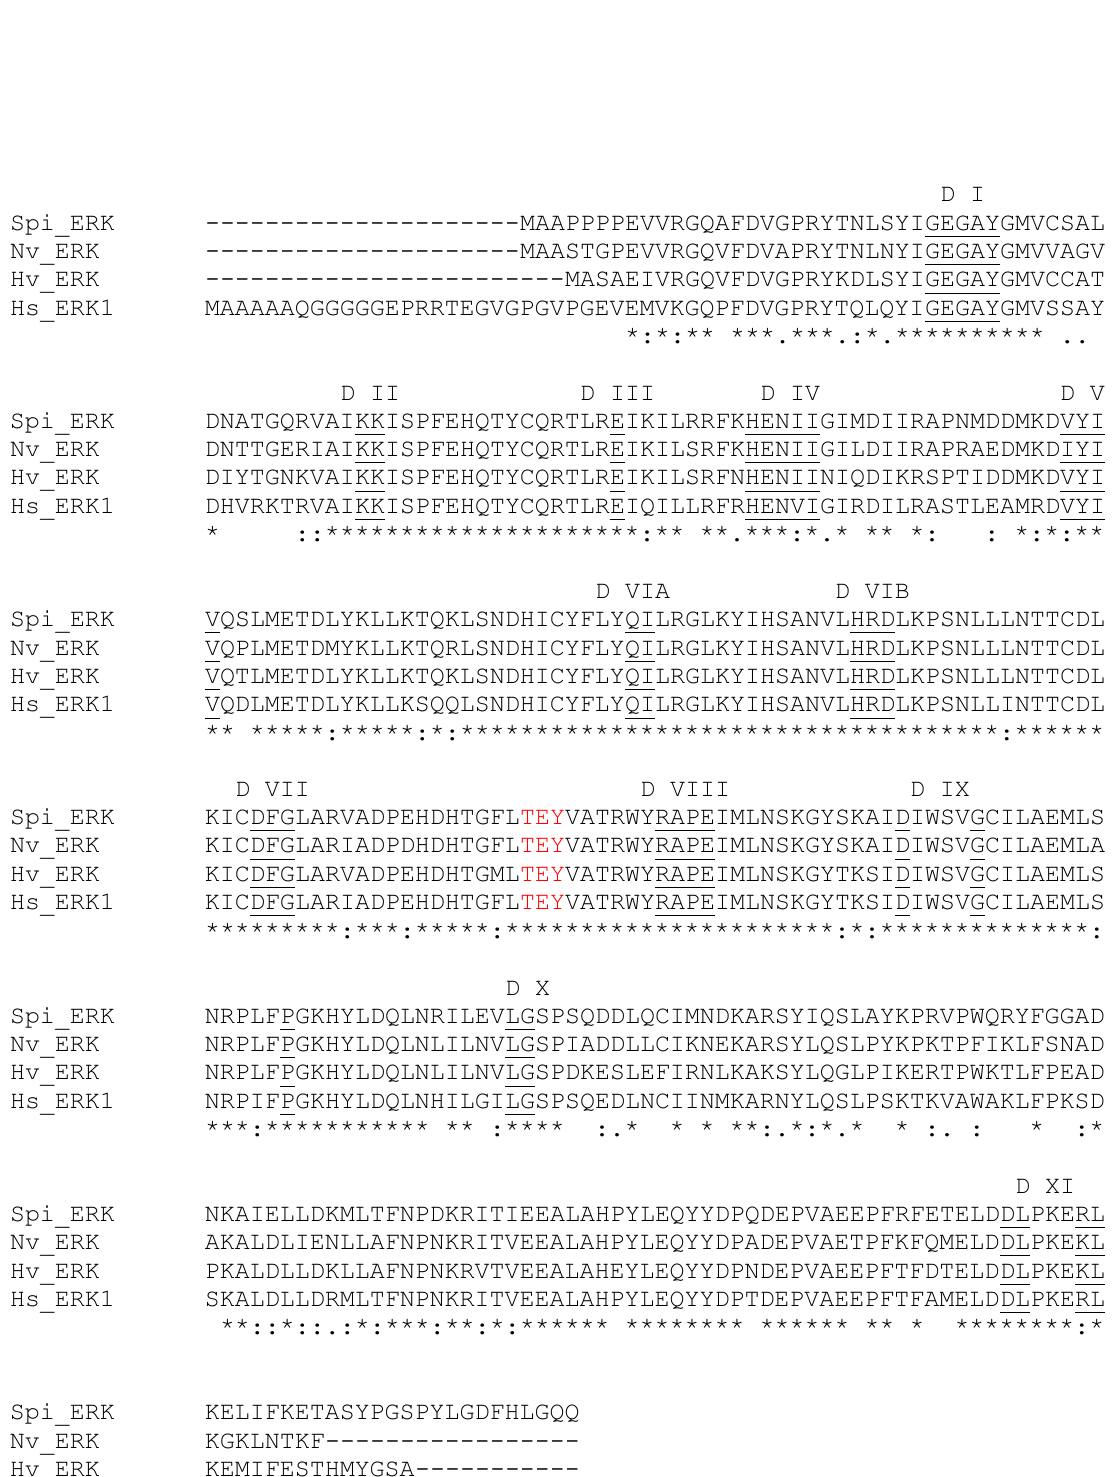
Figure 1. Sequence alignment of MAPK orthologs. The ERK orthologs of Stylphora pistillata (Spi-ERK), Nematostella vectensis (Nv-ERK), Hydra vulgaris (Hv-ERK), and the human ERK1 (Hs-ERK1) protein sequences are shown. The ERK-specific TEY motif is highlighted in red. The eleven conserved kinase domains are